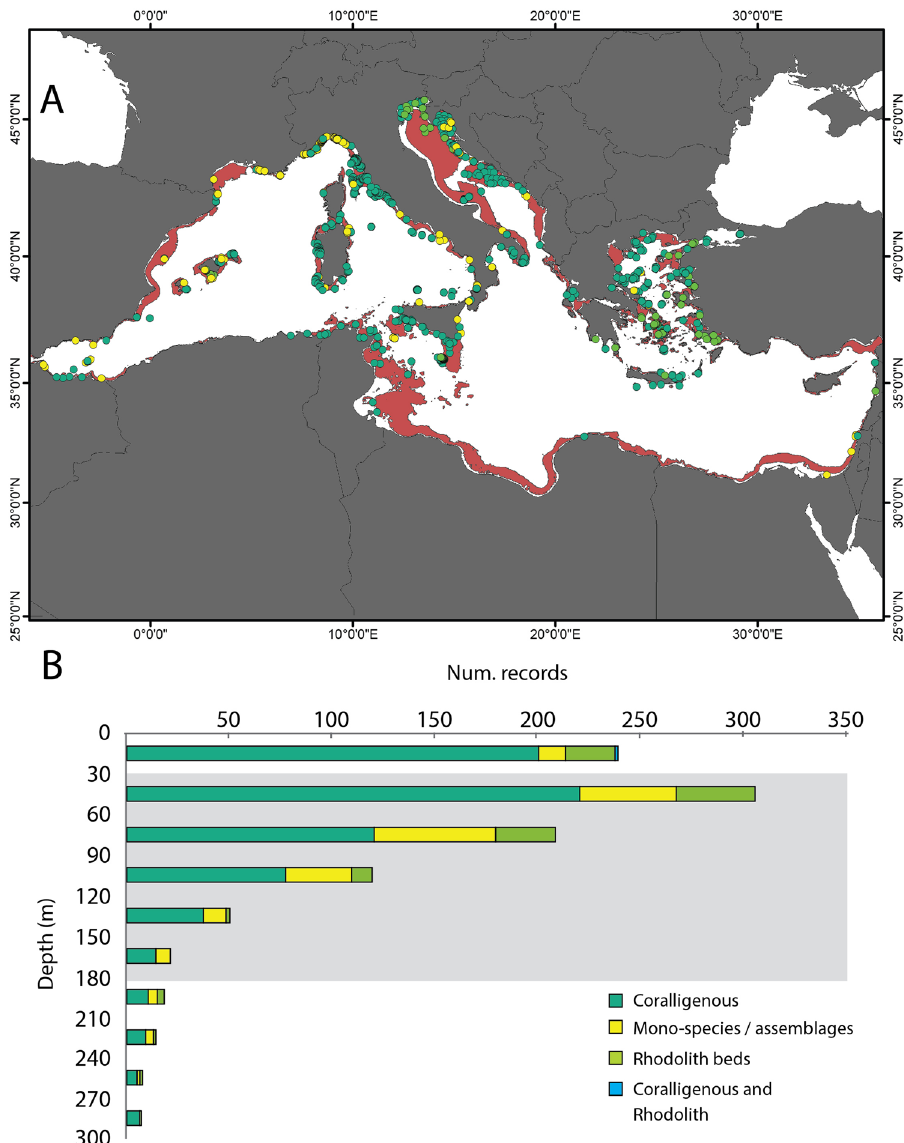
Figure 5. Spatial information on Mediterranean mesophotic ecosystems in the literature. ( A ) Map showing the locations of mesophotic assemblages sourced from literature data and the sites with coralligenous formations and rhodolith beds from the MEDISEH database. The red shaded area indicates the portions of seabed characterized by mesophotic conditions (from this study). Map generated using ArcMap 10.5 software (© ESRI, https:// deskt op. arcgis. com). ( B ) Depth range of the different benthic mesophotic assemblages. The grey shaded area marks the depth range predicted as under mesophotic conditions in the Mediterranean Sea (30–175.5